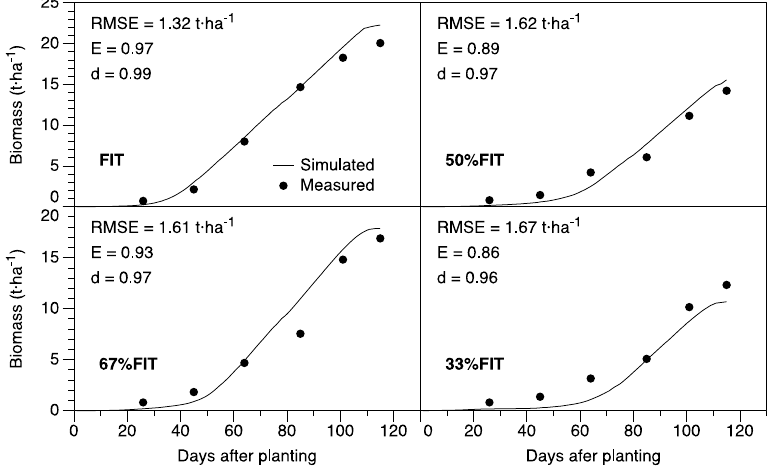
Figure 6. Seasonal progression of simulated and observed aboveground biomass used in model validation.